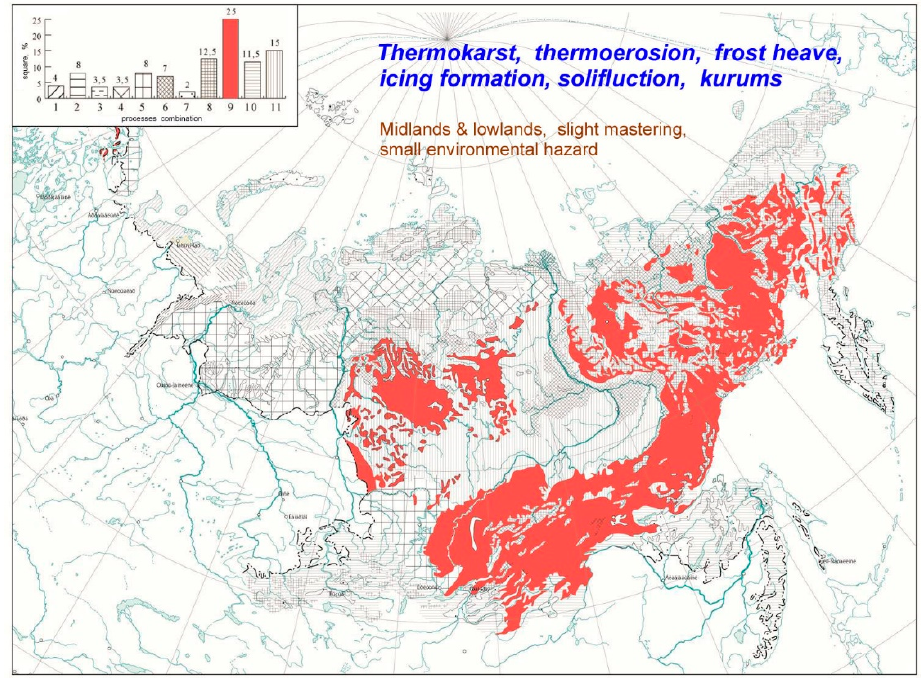
Figure 15. The first group of processes combinations (red color).